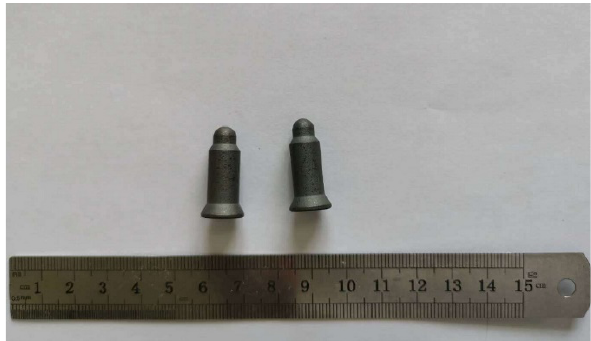
Figure 11. Photograph of spot welding location pins made from the studied alloy.